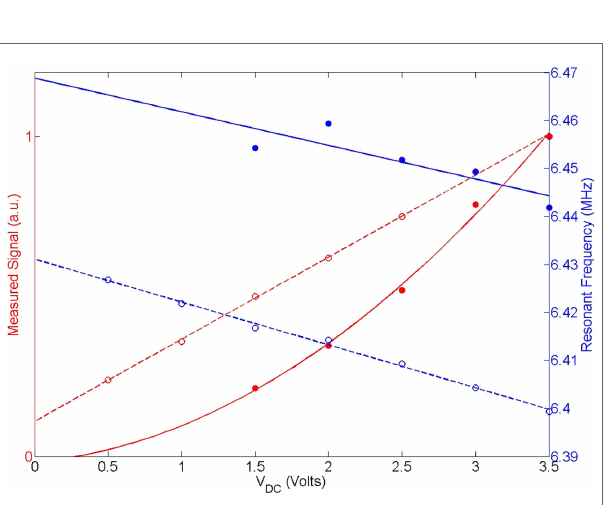
FigUre 6 | graph describing the variation of peak height (red) and resonant frequency (blue) with V dc1 using both optical (empty circles) and capacitive (filled circle) sensing methods . The guiding lines are plotted using a linear curve fit, with the exception of the solid red line that uses a quadratic curve fit. The graph corresponds to the response given by the first cavity of the device, with fundamental resonant frequency, f 0 , value of around 6.44